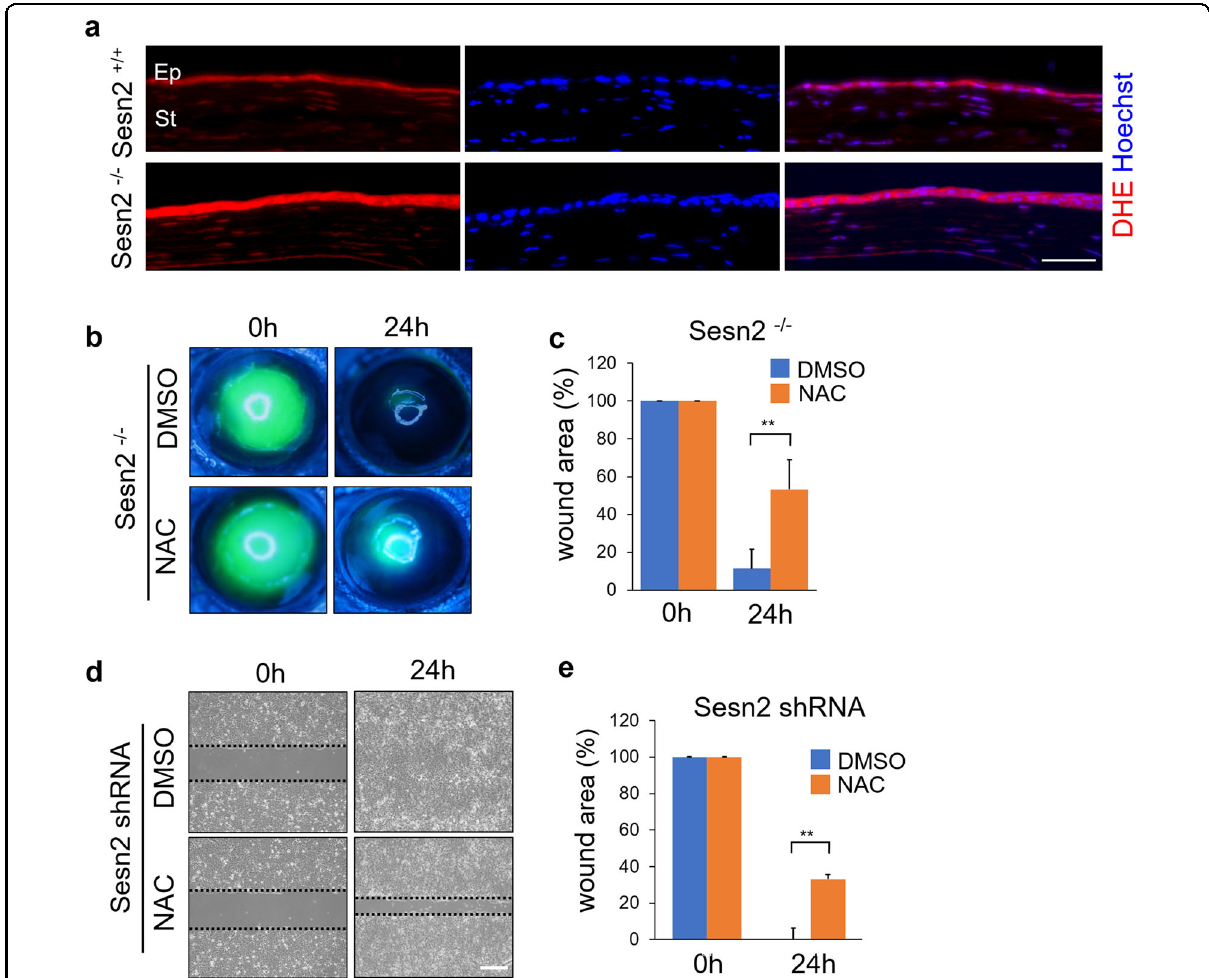
Fig. 5 ROS levels increase in Sesn2-de fi cient corneal epithelium, and the inhibition of ROS suppresses corneal wound healing. a Detection of ROS by DHE staining in the sections of the injured corneas from Sesn2 − / − and Sesn2 + / + mice. DHE fl uorescence intensity in the corneas of Sesn2 − / − mice was signi fi cantly higher than that in the corneas of Sesn2 + / + mice. b In vivo corneal epithelial wound healing of Sesn2 − / − mice after injury using a 2 mm punch. Each cornea was treated with 2 mM NAC or DMSO after injury. c Quantitative analysis of the corneal wound area of Sesn2 − / − mice treated with NAC or DMSO. Inhibition of ROS suppressed corneal wound healing. d In vitro wound healing assay of hCET cells expressing Sesn2 shRNA treated with 2 mM NAC or DMSO. e Wound closure in NAC-treated hCET cells was delayed than that in DMSO-treated cells. Error bars represent the means ± SD of three independent experiments. Two-tailed Student ’ s t -test (** p < 0.01). Scale bar, 50 µm in ( a ); 300 µm in ( d